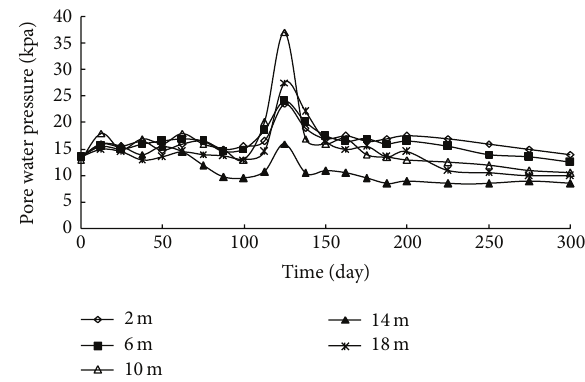
Figure 17: Excess pore water pressure with depth obtained by the theoretical